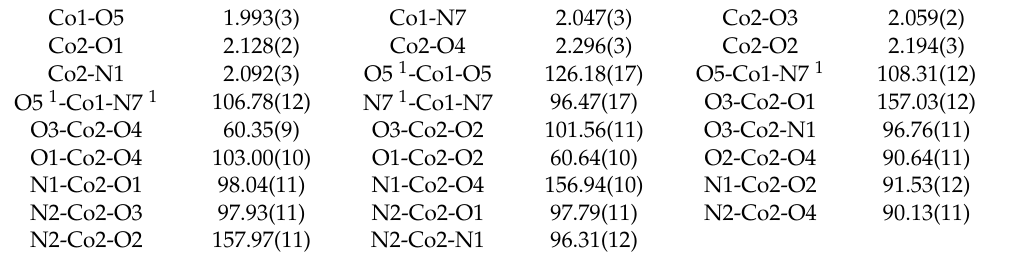
Table 2. Selected bond lengths ( ´ Å) and angles